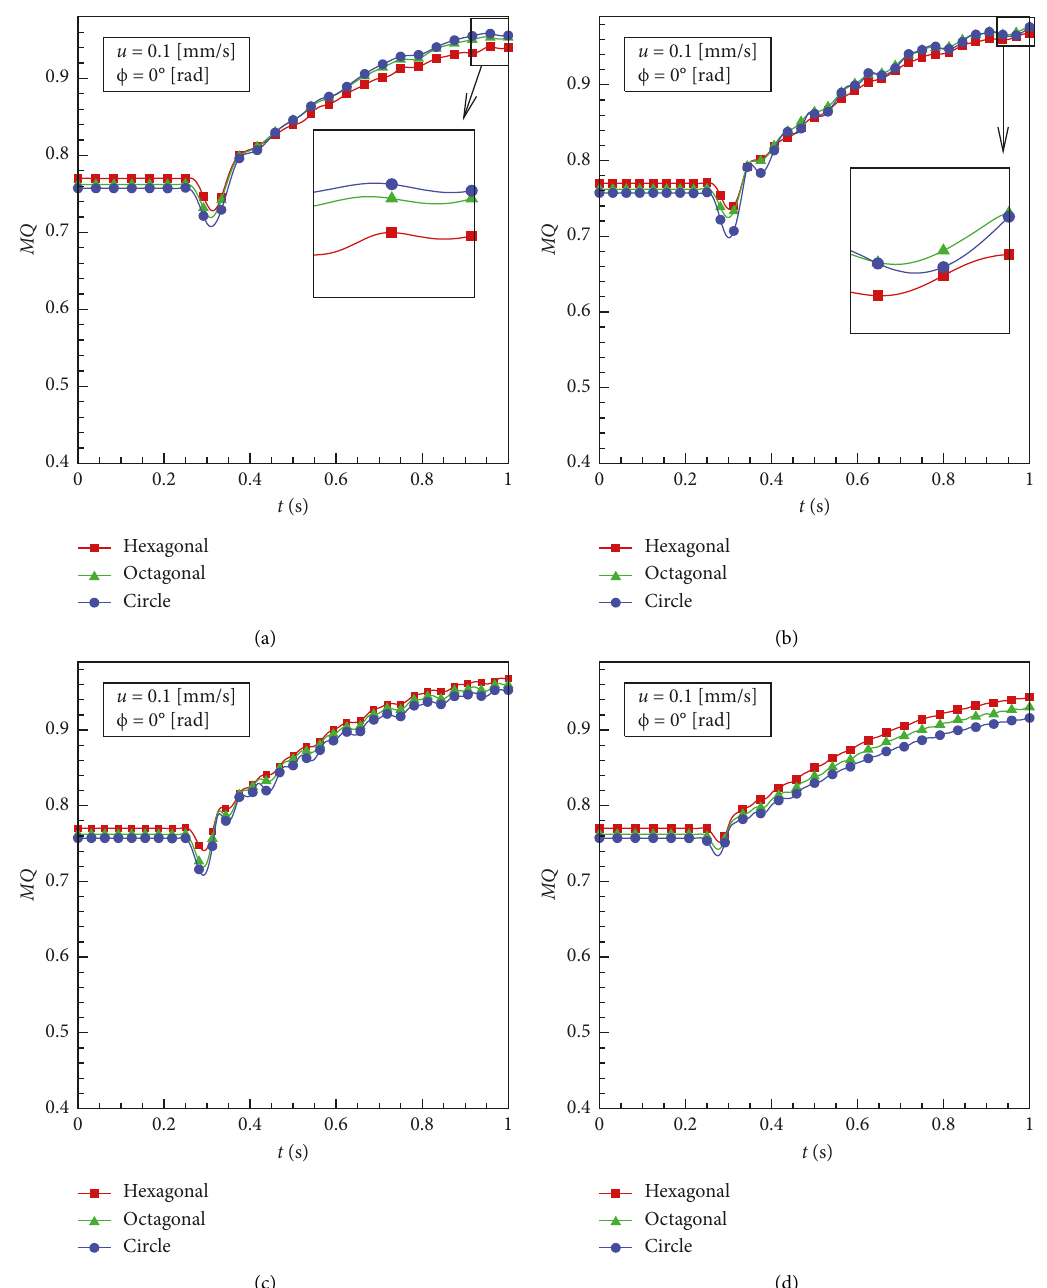
Figure 6: Mixing efficiency variation based on time in three mixing chambers at u � 0.1mm · s − 1 and φ � 0 for different frequencies: (a) 5Hz; (b) 7 Hz; (c) 10Hz; and (d) 15